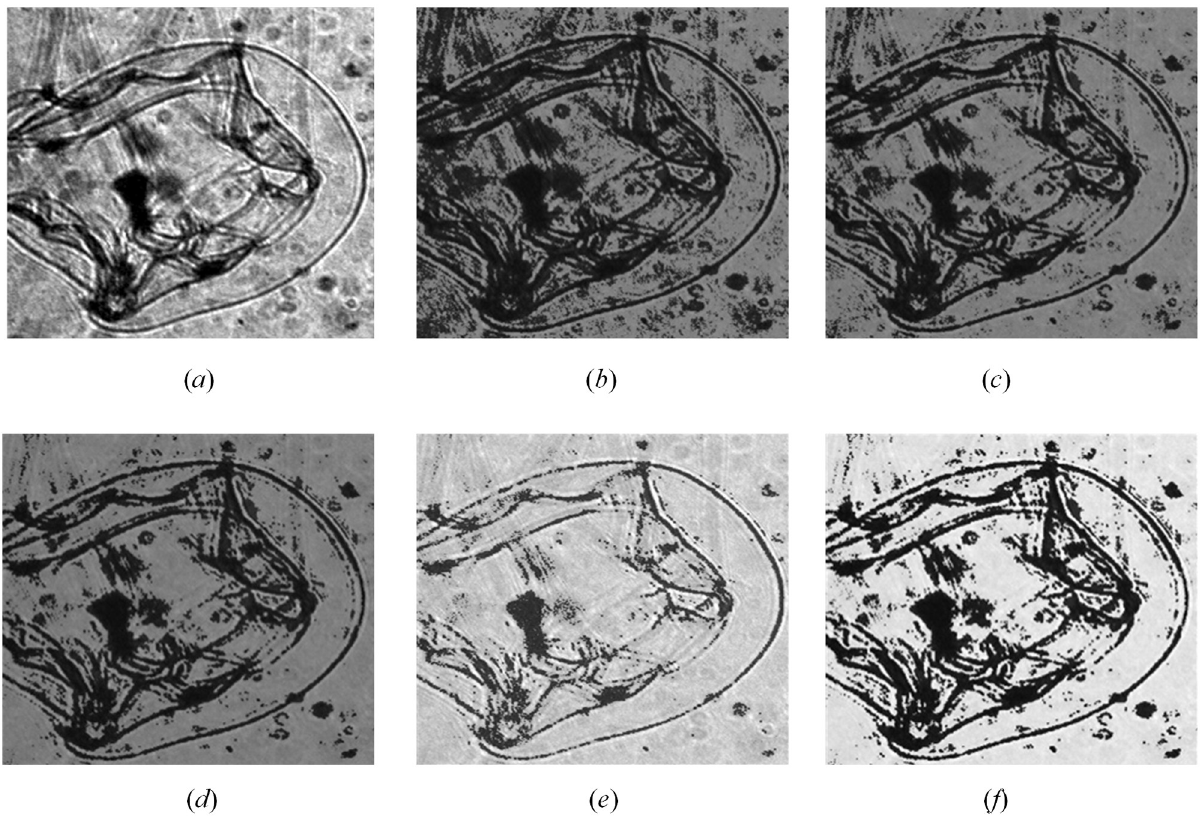
Fig 5. Effects of different δ on ROI enhancement. ( a ) Original ROI, the contrast of which is adjusted only for illustration purpose due to the heavy darkness of original ROI, and the procedure directly use the original ROI; ( b ) δ = 3.1; ( c ) δ = 3.3; ( d ) δ = 3.5; ( e ) δ = 3.7; ( f ) δ = 3.9.